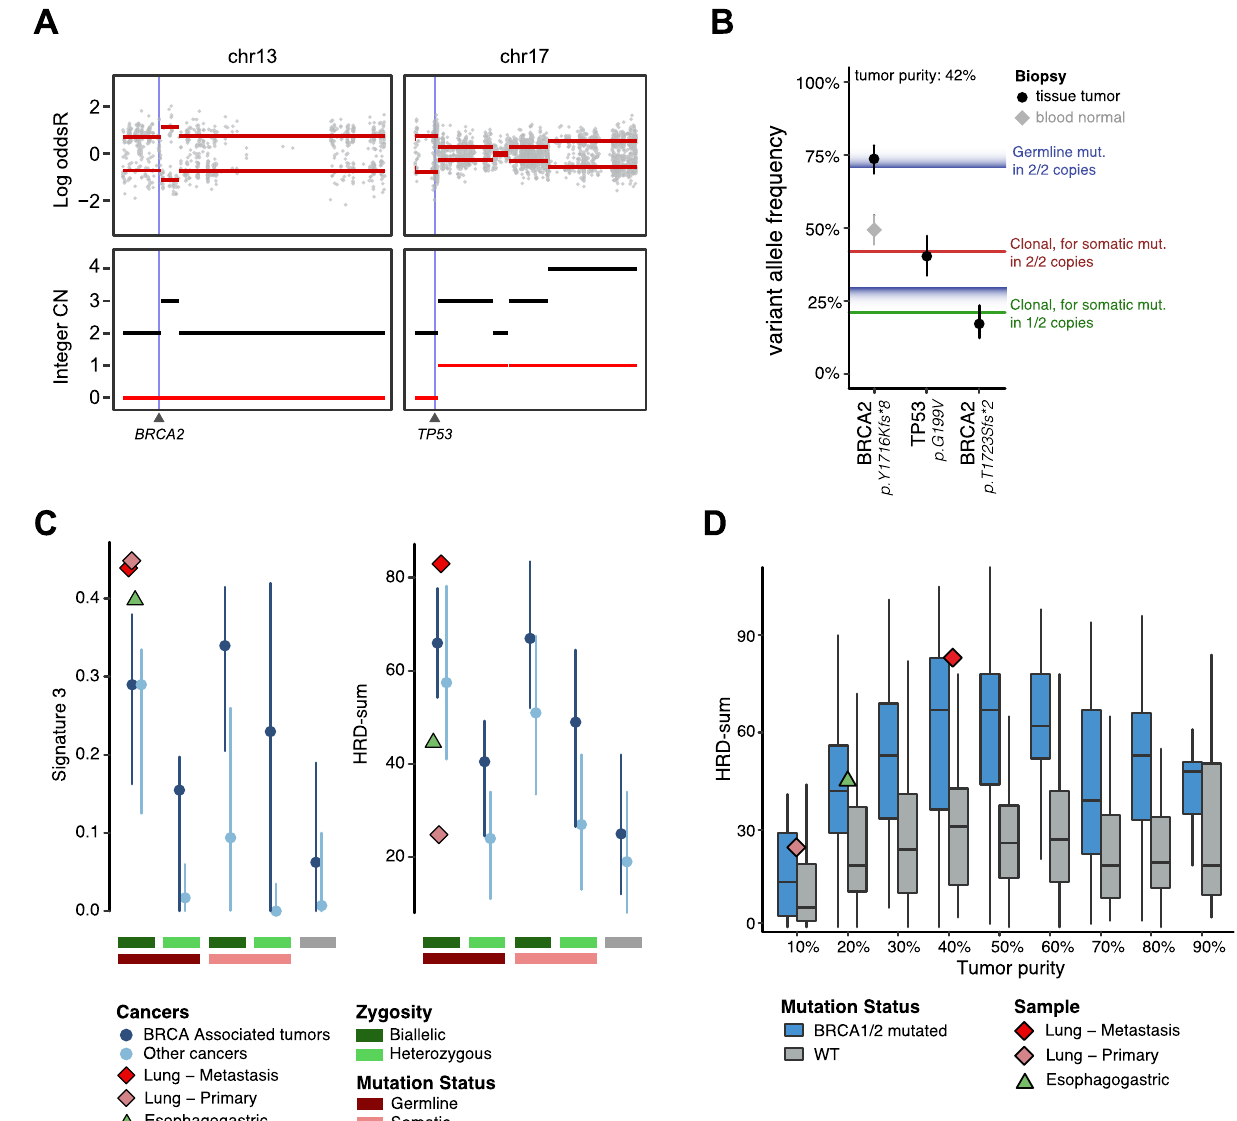
Fig. 4 | BRCA-mediated phenotypes in lung and esophagogastric cancer cases. A In the lung cancer patient, allele-speci fi c copy number pro fi le of the tumor shows a copy-neutral loss of heterozygosity (CNLOH) at both BRCA2 and TP53 loci.ThetopplotshowsthelogoddsratioforheterozygousSNPs(graydots).The bottom plot shows integer copy number. The black line represents total copy number, whereas the red line shows minor copy number. B Variant allele fre- quencies in tumor tissue from the patient with lung cancer (black) and matched normal plasma (gray, BRCA2 germline) are shown for key mutations. The BRCA2 Y1716Kfs*8 germline variant and somatic TP53 G199V somatic mutation show allele frequencies in the tumor consistent with complete loss of WT. The rever- sion mutation is acquired late and is present on one of the two copies of the BRCA2 allele. Mut=mutation. C Left panel shows measures of single nucleotide substitution-based Signature 3 contribution across the previously published 814